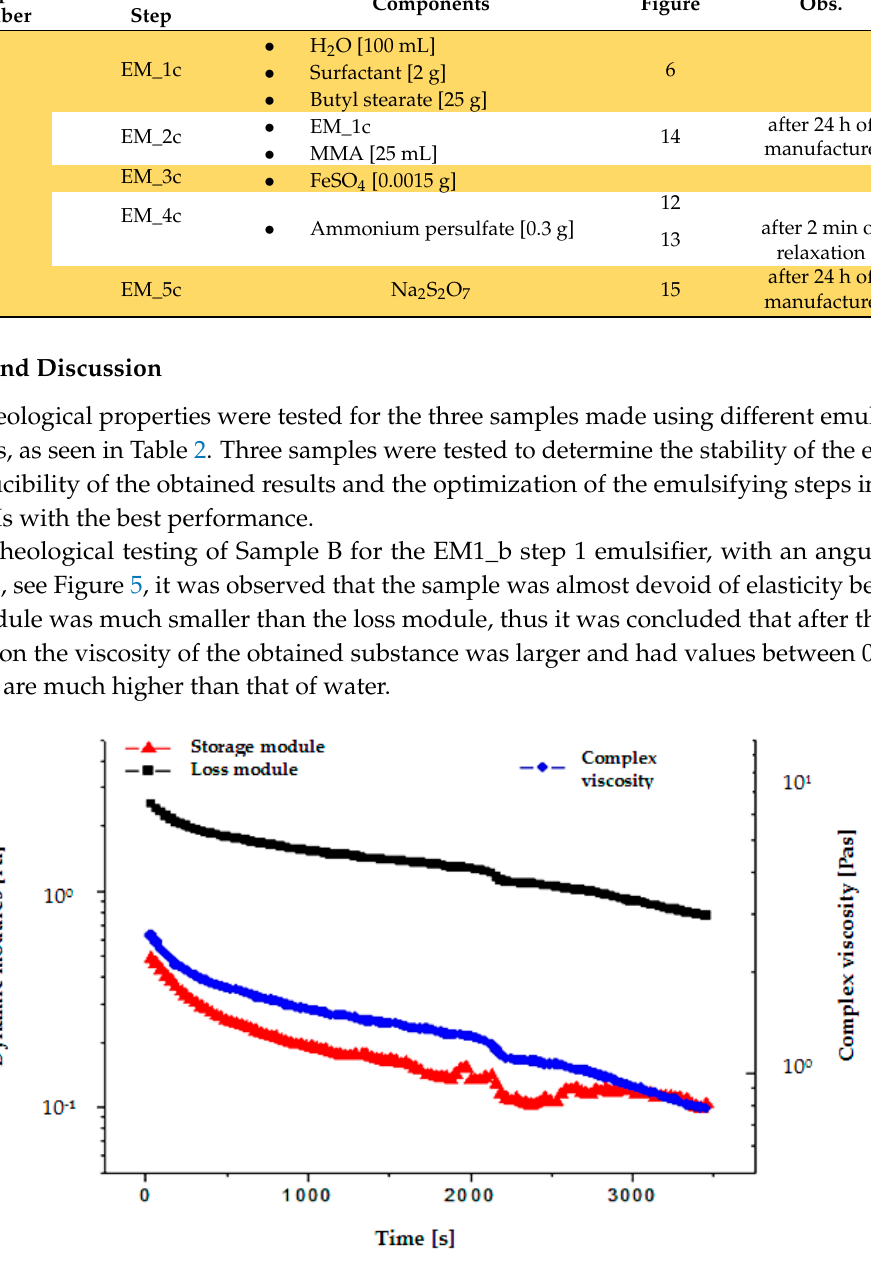
Figure 5. Storage module, loss module and complex viscosity for EM_1b.